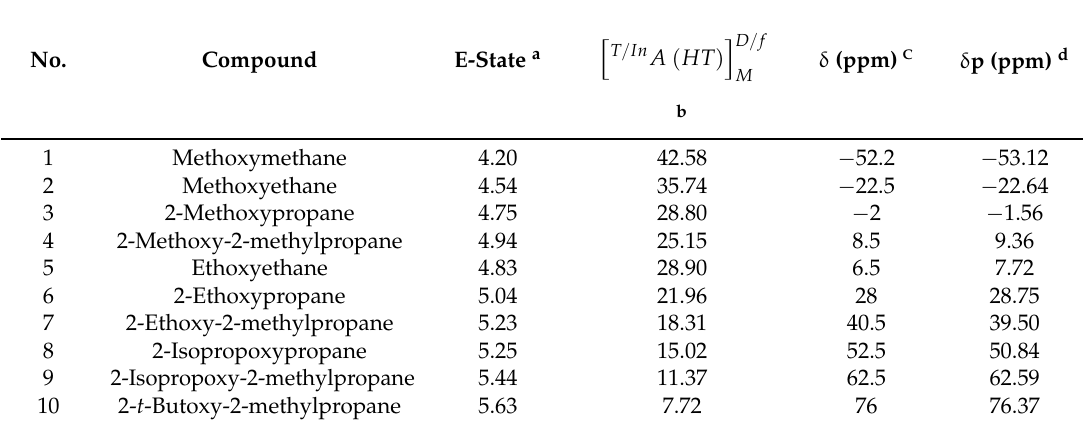
Table 11. Chemical Shift p δ q in 17 O-NMR and GDI